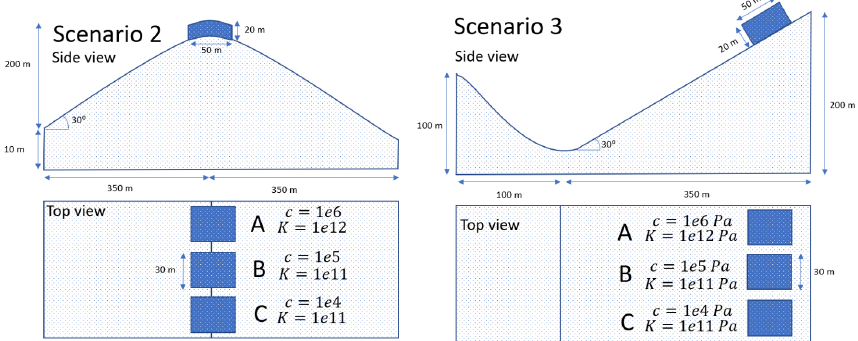
Figure 6. The dimensions of the numerical experiment setups used in this work: setup 1 (left) and setup 2 (right).